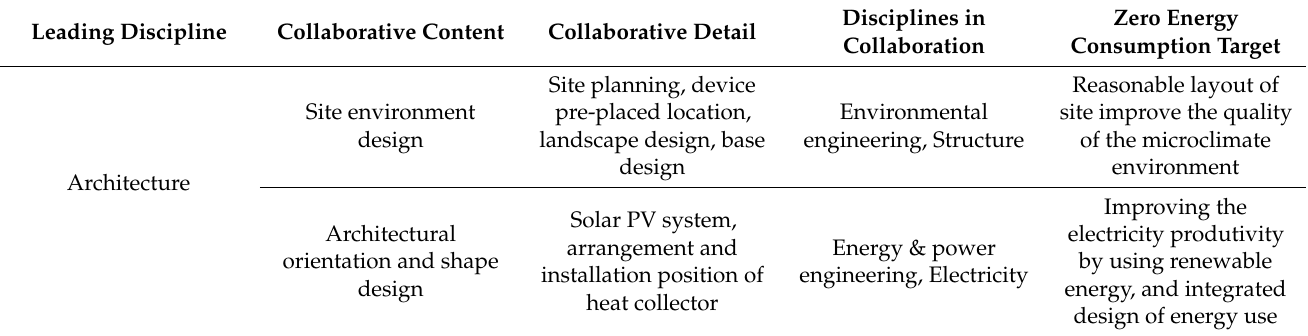
Table 2. Collaborative design in the preliminary design stage.